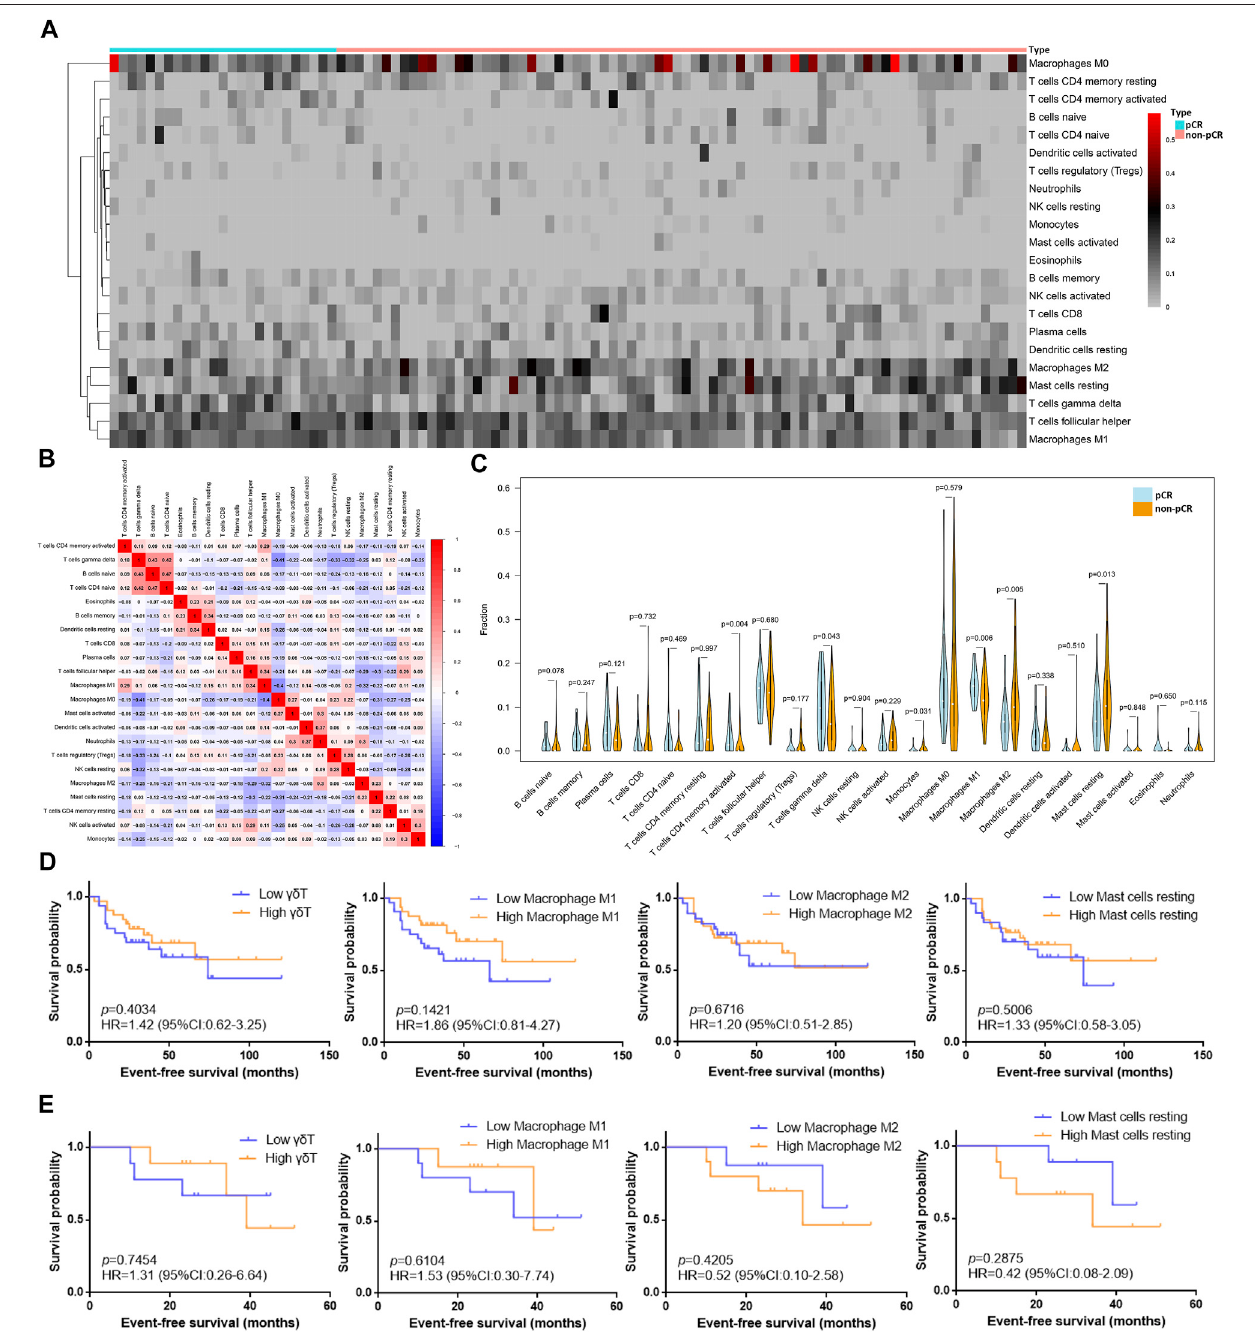
FIGURE2| DifferencesbetweenimmunecellfractionsoftheTIMEinBCpatientswithdifferentNACresponses. (A) Heatmapofthefractionof22immunecelltypes forcomparisonbetweenpCRsamplesandnon-pCRsamplesfromdatasetGSE32646.Theredderpointsintheheatmapindicatethatthefractionofimmunecellsinthe corresponding sample was higher, while the gray points indicate lower fraction. (B) Correlation of 22 immune cells in the TIME from dataset GSE32646: Red represents positive correlation, blue represents negative correlation, and the depth of color indicates the strength of correlation. (C) Differential analysis of 22 immune cell fractions in pCR and non-pCR samples from dataset GSE32646. Blue represents pCR samples and orange represents non-pCR samples, and p value represents the statistical signi fi cance of the differential analysis between the two groups for each immunecell. (D) Survival analysis of different grouping by immune cells subtypes in 63 TNBC samples from dataset GSE31519. (E) Survival analysis of different grouping by immune cells subtypes in 18 TNBC samples received NAC from dataset GSE31519.